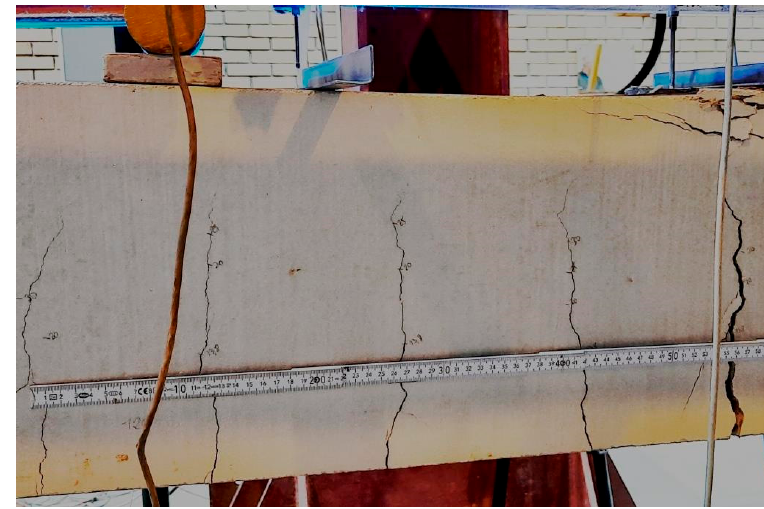
Figure 11. The cracking pattern captured by marking in RC beam.